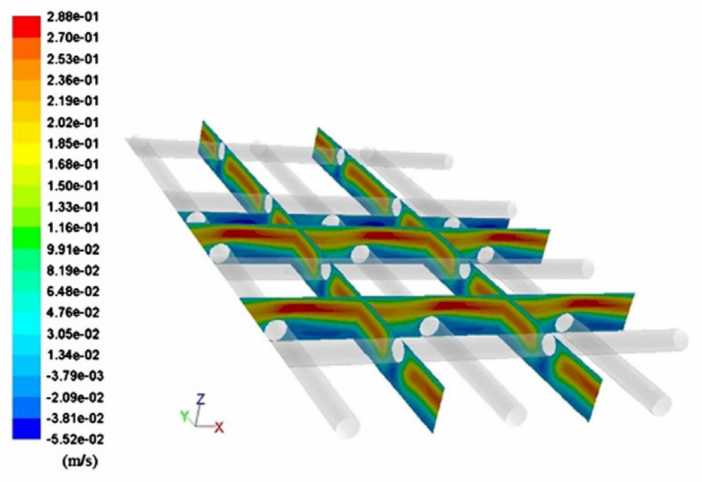
Figure 19. X-Velocity contours of the fluid flowing through the membrane [54]. Reproduced with permission from Elsevier, 2012.